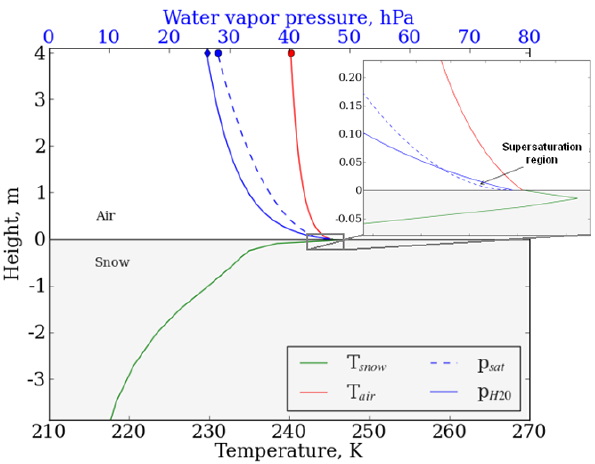
Figure 6. Atmosphere saturation ratio as a function of (1 + mµ)e − mµ . The different markers correspond to the three days of the measurements period. Dots are only indicated if the surface is warmer than the far field. The white area corresponds to regime VI (Table 1) and the greyed area to regime V. Time given is local